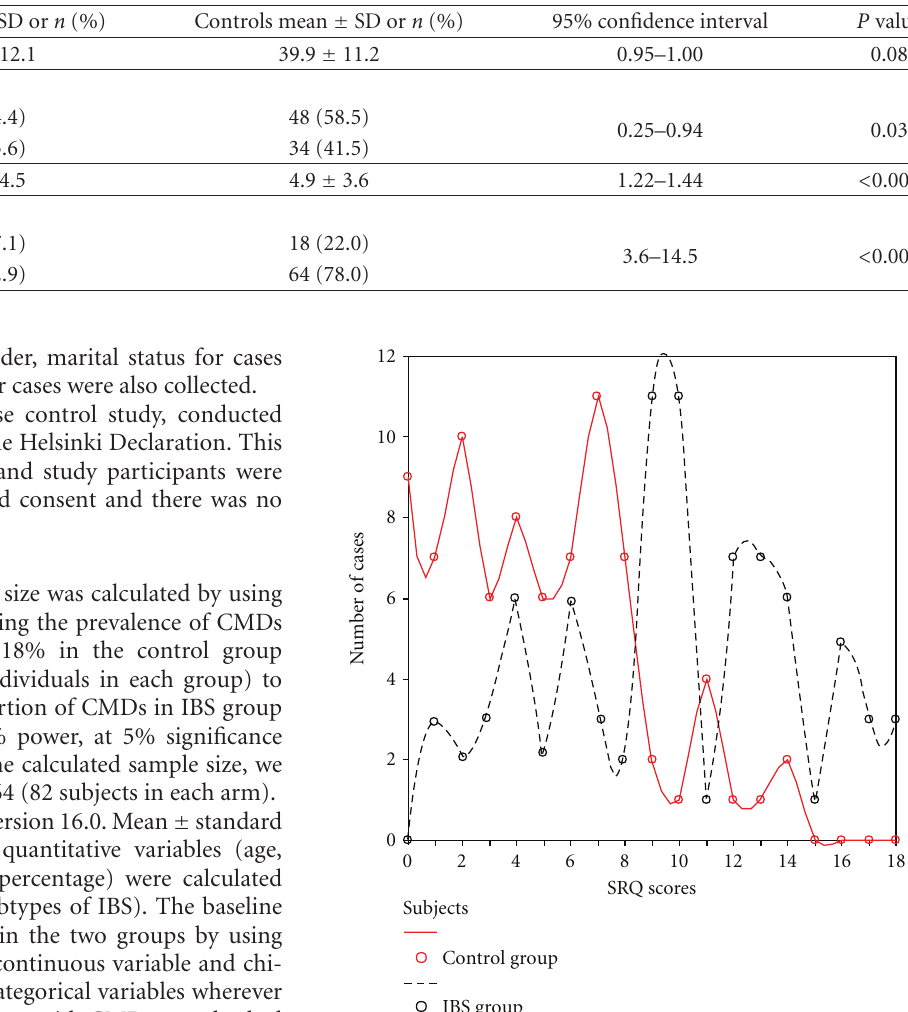
Table 1: Comparison among patients with IBS and controls.